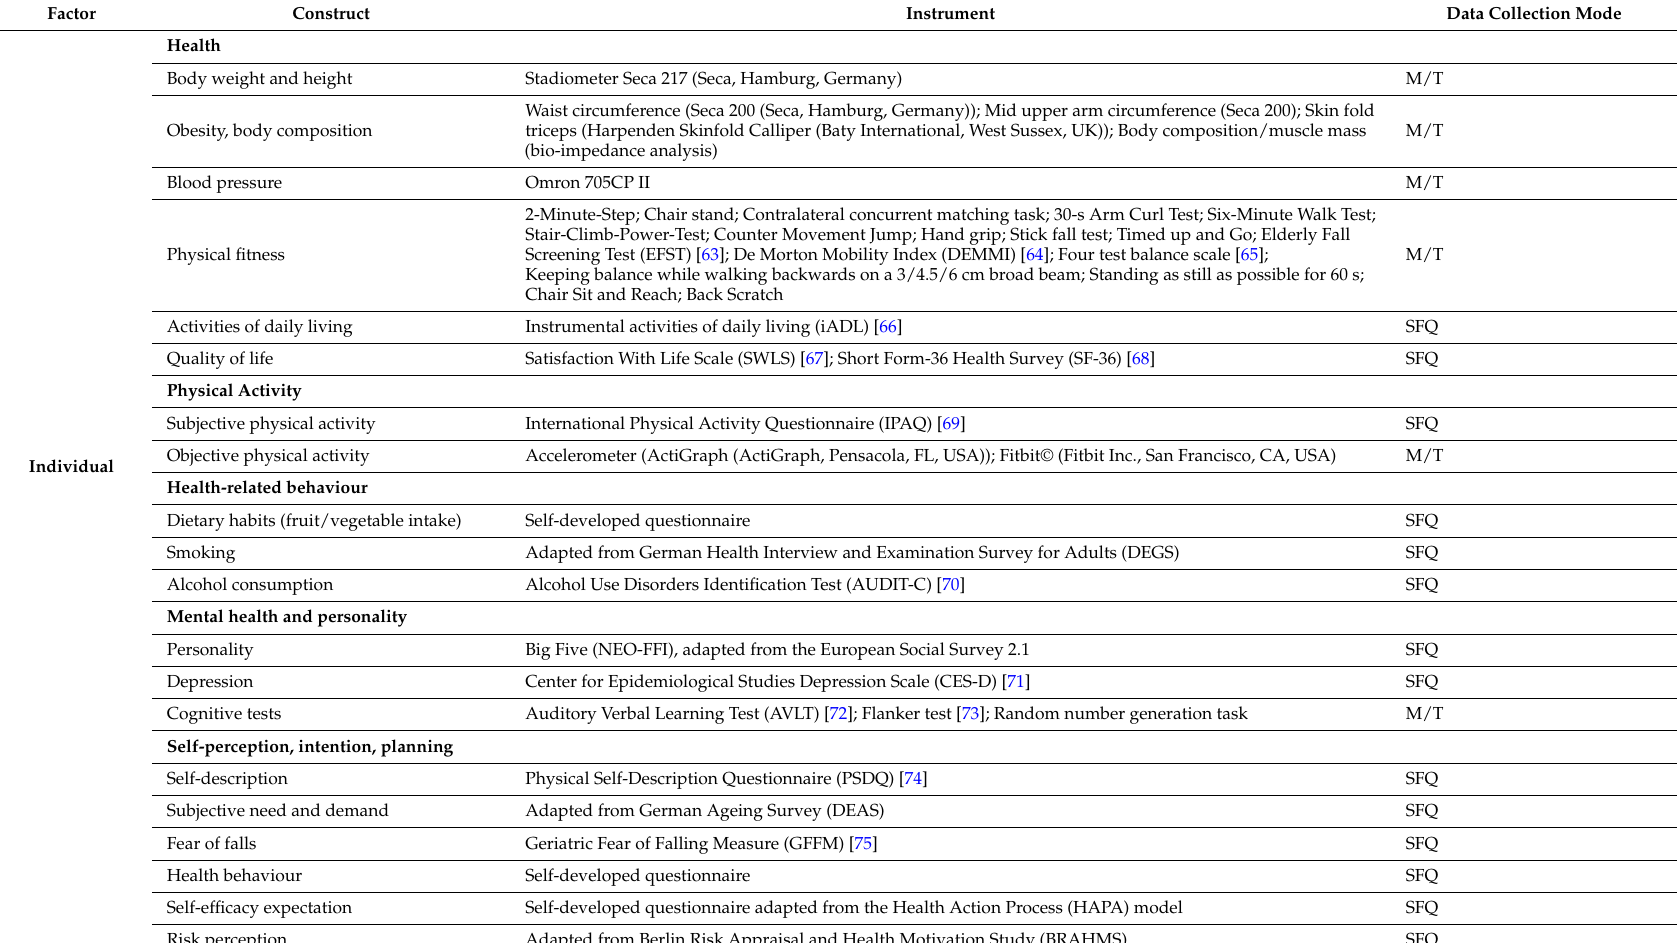
Table 2. Factors, constructs and instruments/methods used within AEQUIPA sub-projects a